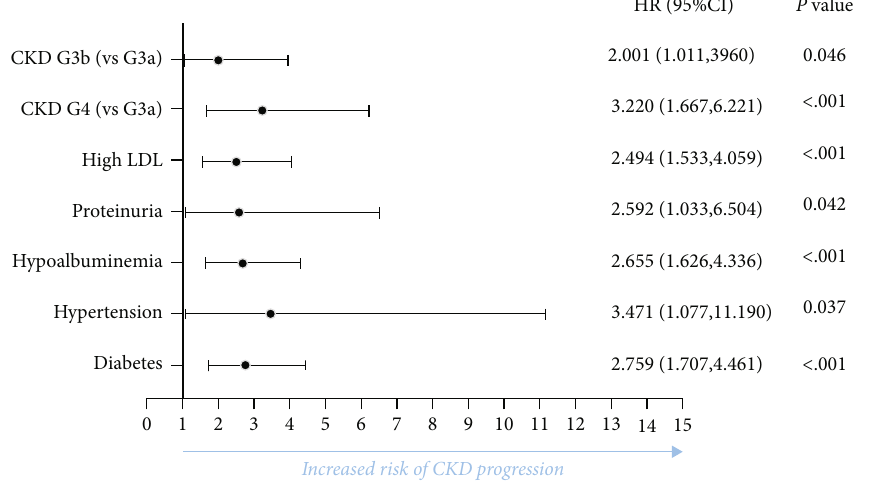
Figure 2: Baseline characteristics associated with CKD progression using multivariate analysis. Table 5: Multivariate analysis of factors a ff ecting the CKD progression among patients with or without diabetes. Without diabetes With diabetes Variable B